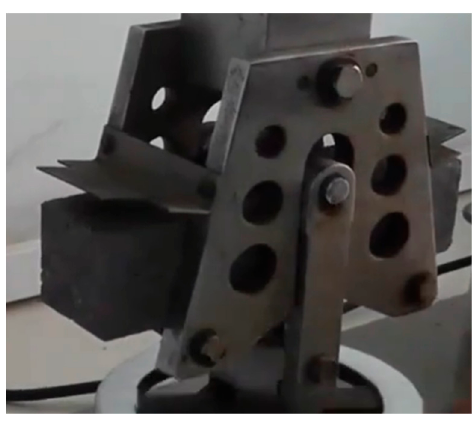
Figure 2. Specimen being fixed in the holder of the electric flexure tester.